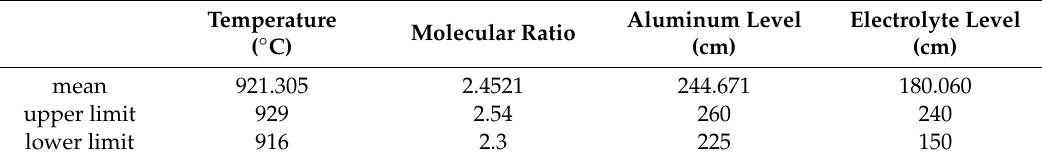
Table 4. Range of aluminum electrolytic cell parameters.